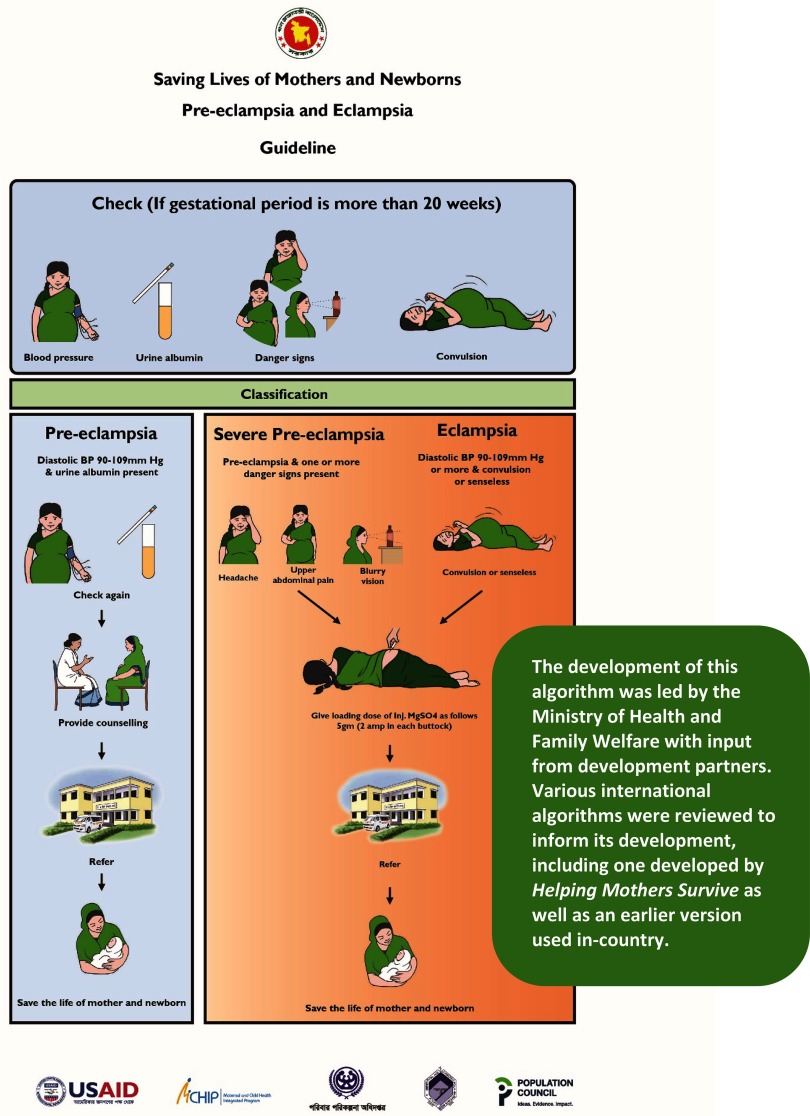
Pictorial Algorithm for the Management of Women With PE/SPE/E Developed by the Ministry of Health and Family Welfare, BangladeshAbbreviations: BP, blood pressure; MgSO4, magnesium sulfate; PE/SPE/E, preeclampsia, severe preeclampsia, or eclampsia.